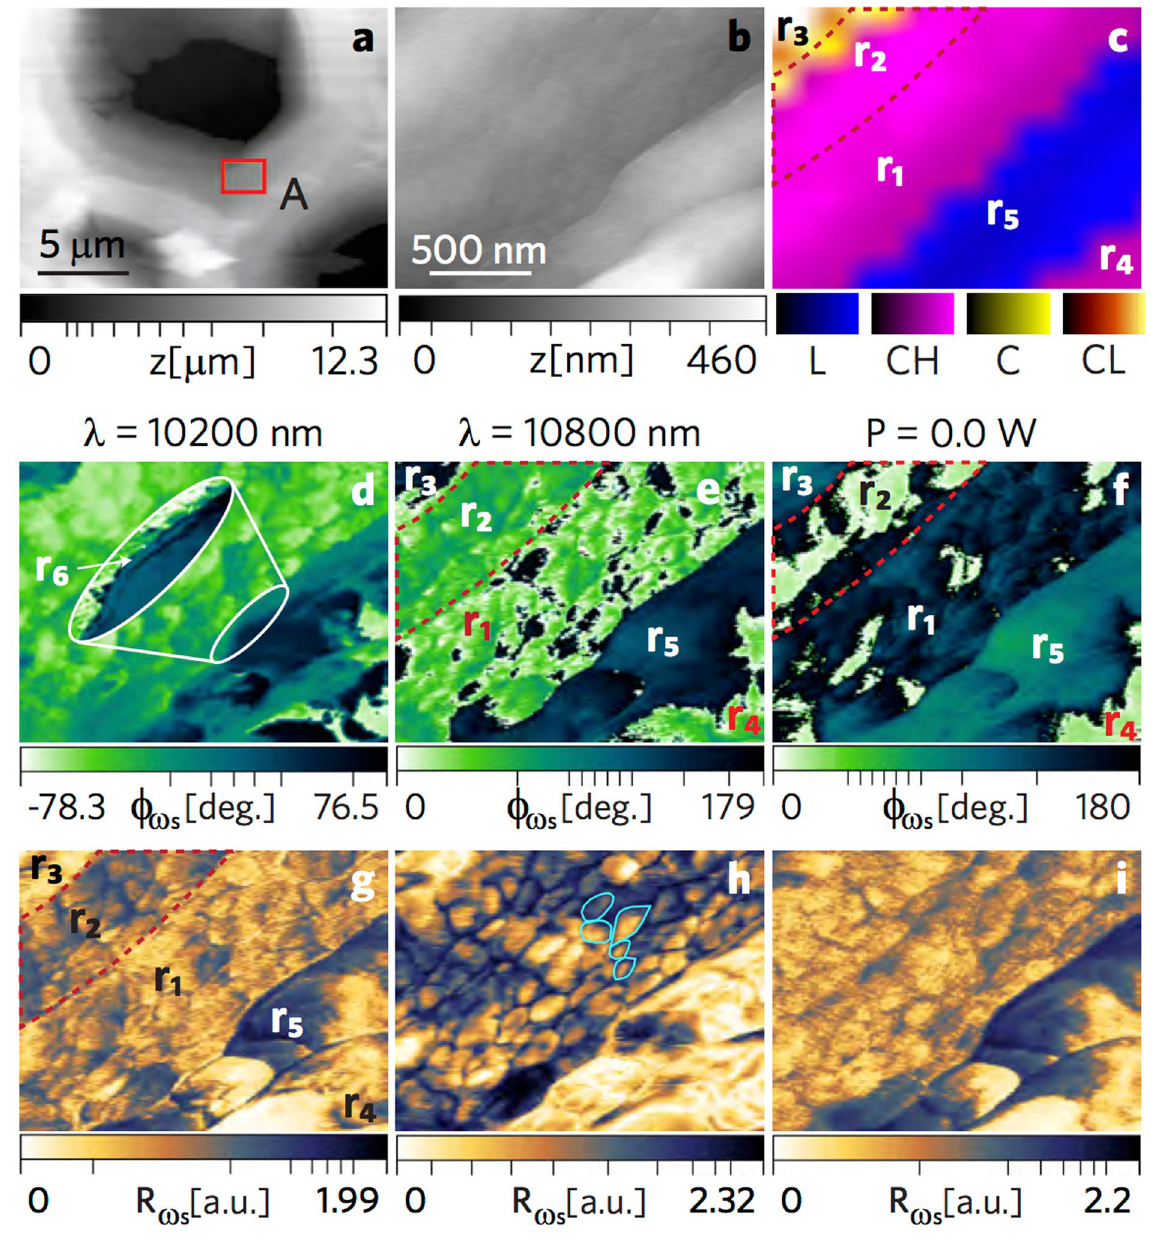
Figure 5. Resolving cell wall ultrastructure and chemistry. HPFM image acquisition via frequency mixing involving photoacoustic sample (EF) actuation and cantilever multifrequency oscillations. The photoacoustic sample actuation was achieved using an amplitude modulated quantum cascade laser tuned to a low absorption channel at λ = 10800 nm and a high absorption channel at λ = 10200 nm. ( a ) Contextual AFM image indicating the examination area, A. ( b ) Topography of A with contact mode AFM (height z). ( c ) Raman image over A with marked regions, r 1 through r 5 , of the cell sturcture. ( d , e , f ) Phase φ ω images at a laser wavelength of s λ = 10200 nm and λ = 10800 nm at P = 1.3 mW, and P = 0 mW (no photonic actuation), with region r 6 identified in ( d ) (see the supplementary materials). ( g , h , i ) Corresponding amplitude images to the above phase images, with 100 to 200 nm wide cellulose agglomerates outlined in ( h